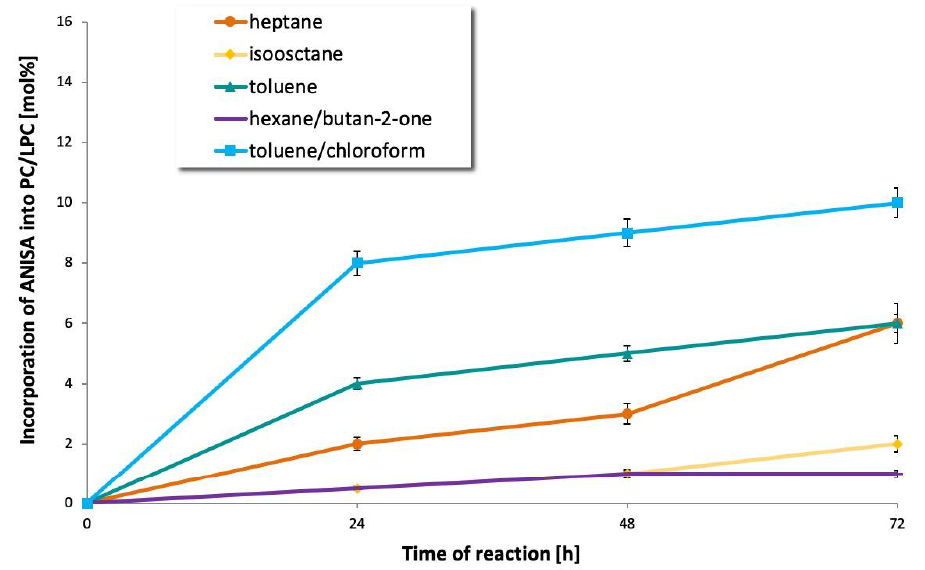
Figure 2. Effect of organic solvent on incorporation of ANISA into egg-yolk PC in the acidolysis reaction (reaction conditions: 1:5 PC/ANISA molar ratio, solvent 2 mL, enzyme load 30% (w/w) Novozym 435, temperature 50 °C). Vertical bars represent SD, n = 3.